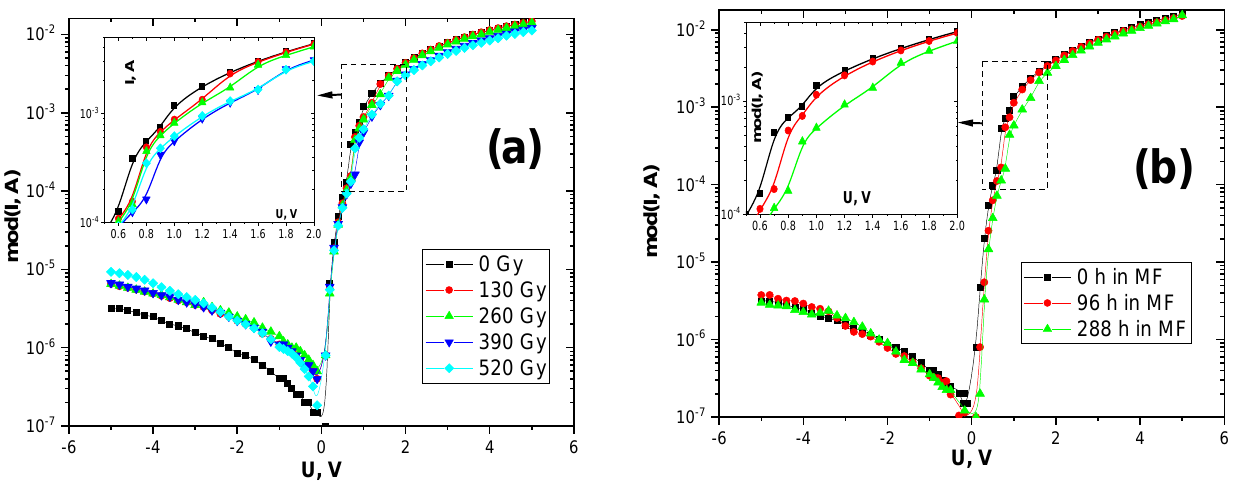
Figure 2. Radiative ( a ) and magnetic ( b ) stimulated changes of current – voltage characteristics in the Bi-Si-Al surface barrier structures.